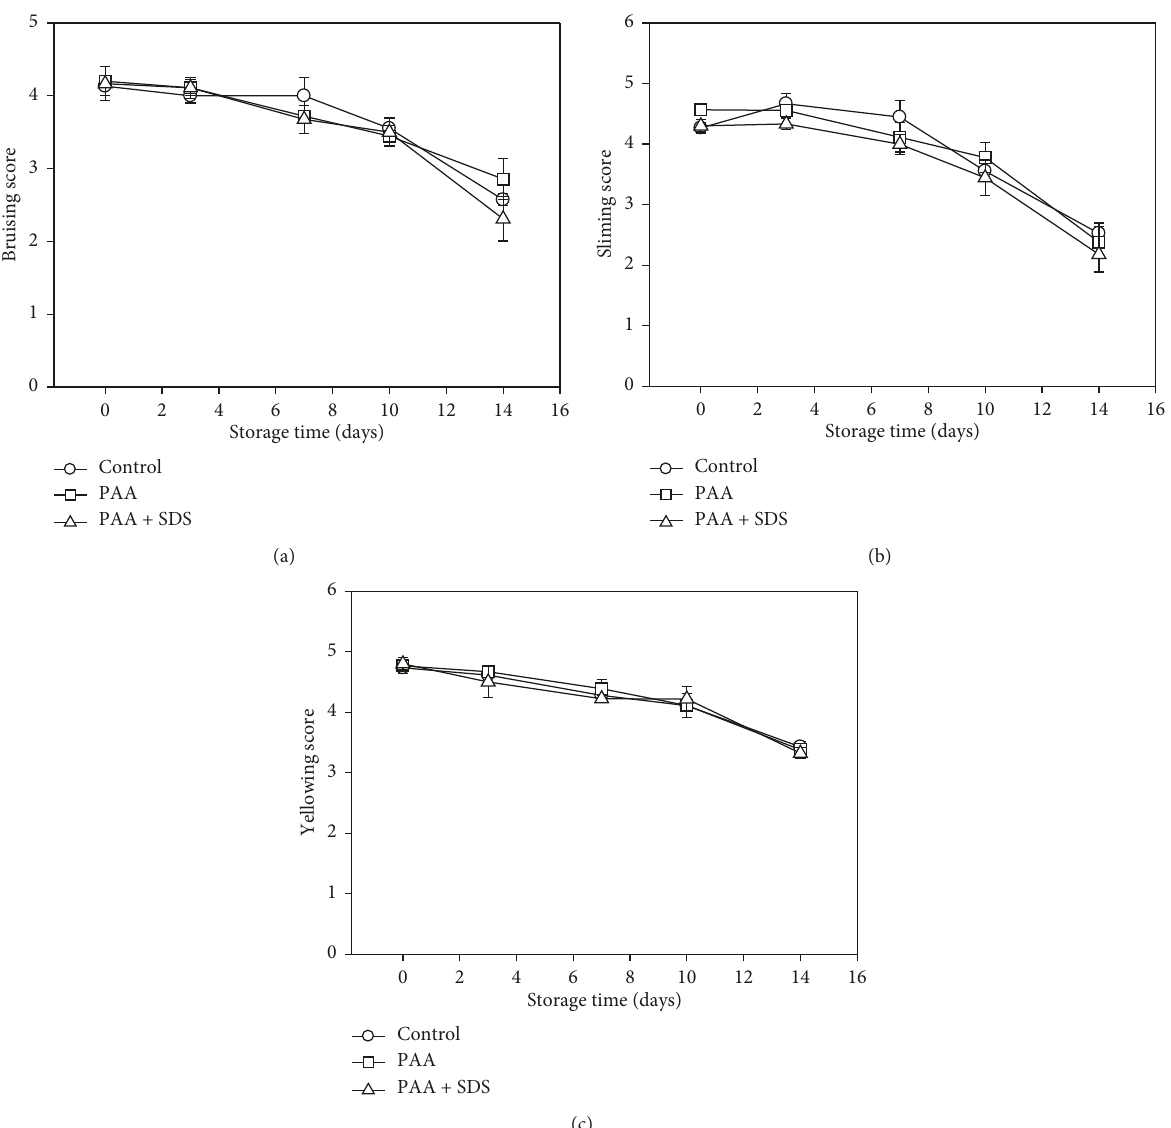
Figure 5: Changes in sensorial attributes: bruising (a), sliming (b), and yellowing (c) scores for baby spinach samples treated with tap water, peroxyacetic acid (PAA), and peroxyacetic acid +sodium dodecyl sulphate (PAA+SDS), stored at 4 ° C for 14d. Error bars represent the standard error of the mean ( n � 7